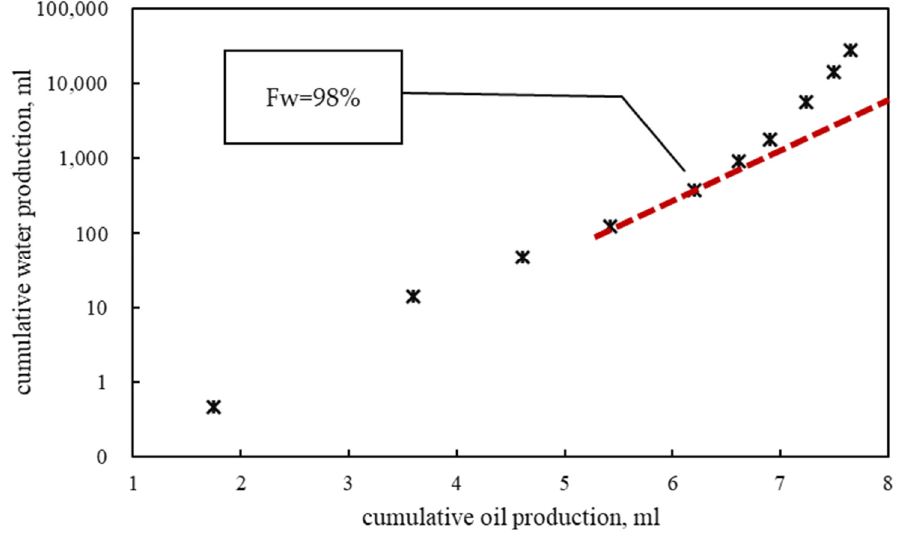
Figure 4. Type A waterflood characteristic curve of #4.